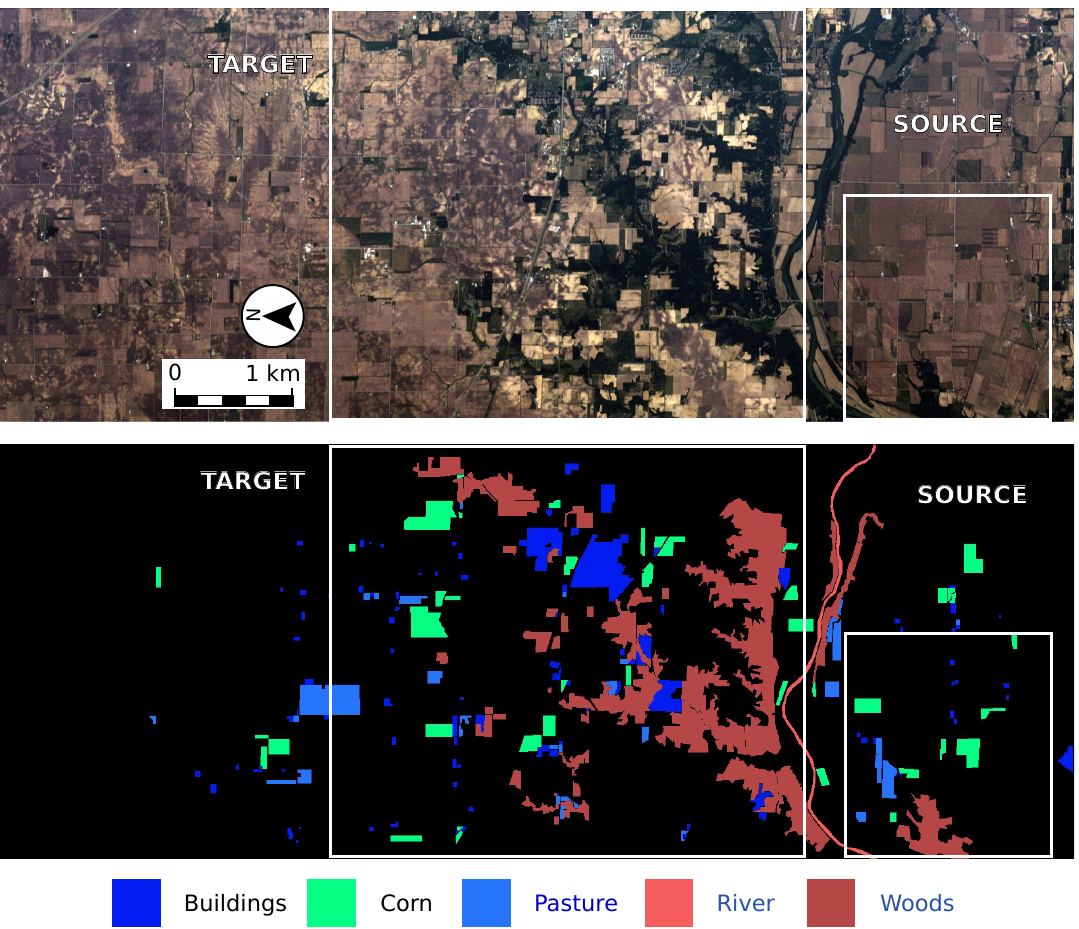
Figure 2. False color composite image, reference data and label meaning for the Indiana